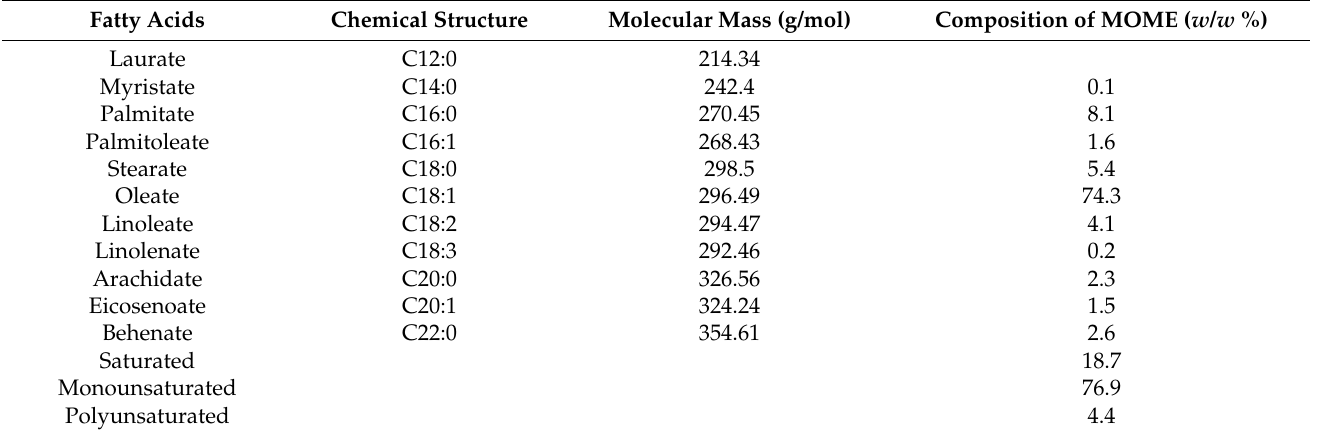
Table 2. Composition of moringa oleifera methyl